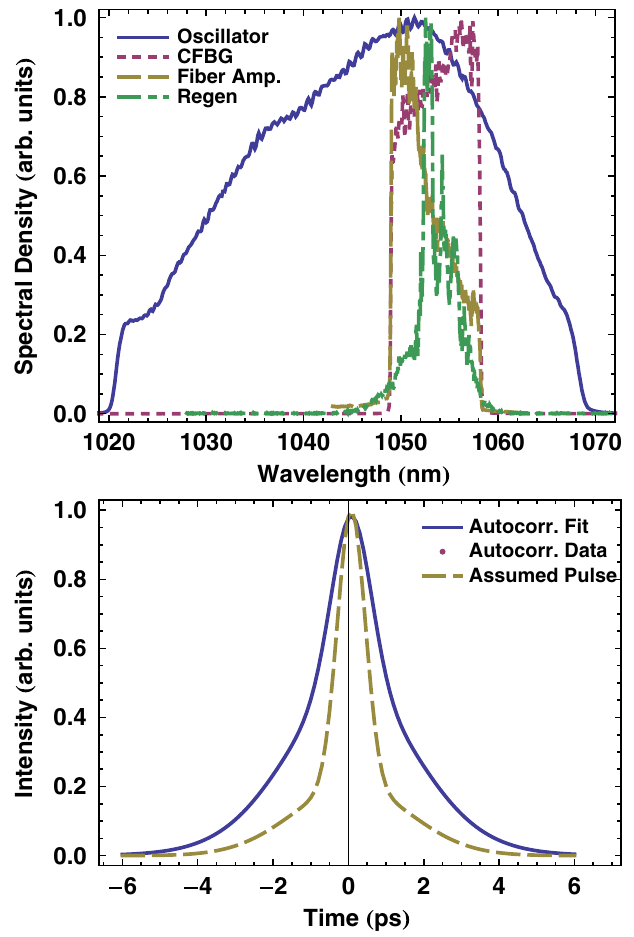
FIG. 3. (Color) Top: The spectrum of the PDL pulse at the oscillator, after the CFBG, after fiber amplification, and after regenerative amplification. Bottom: PDL compressed pulse au- tocorrelation data with a pulse-plus-pedestal fit.